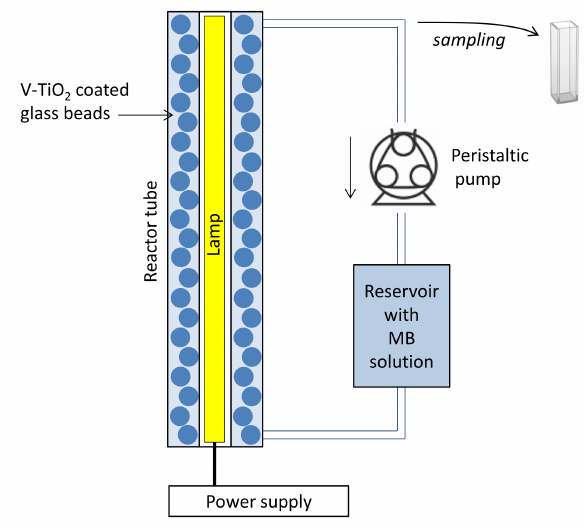
Figure 14. Schema of fixed-bed photocatalytic reactor.